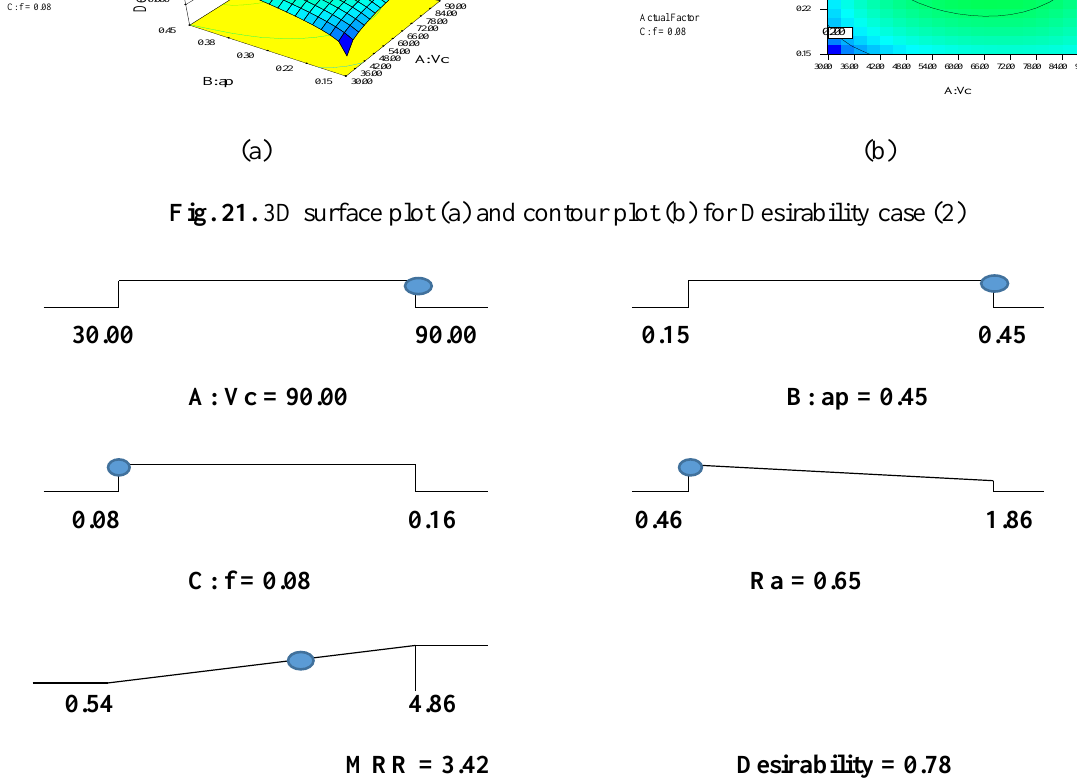
Fig. 22. Solution Ramps of multi-objective optimization for case